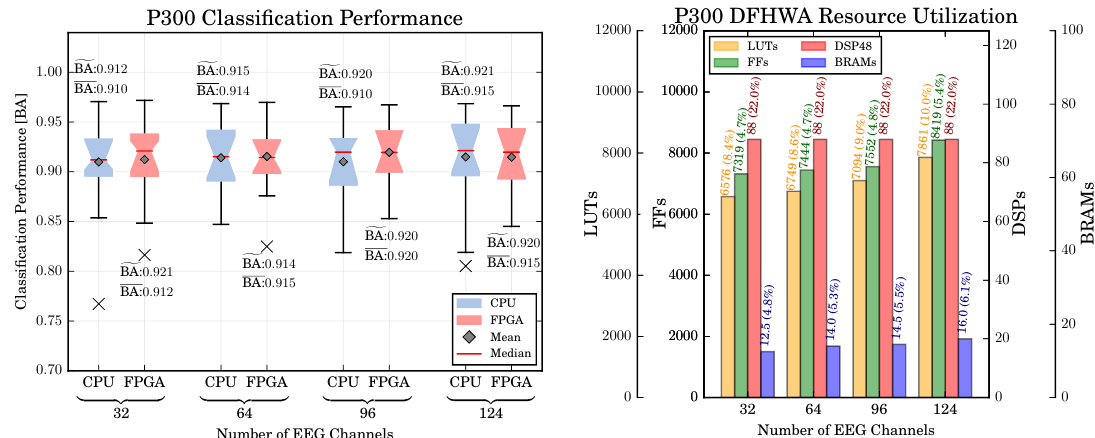
Figure 10. Left: Classification performance of the P300 detection for CPU and FPGA for 32–124 channels. Right: Resource utilization of the DFHWA for different numbers of EEG channels. The percentage values refer to the amount of resources provided by the Zynq ZC7030.